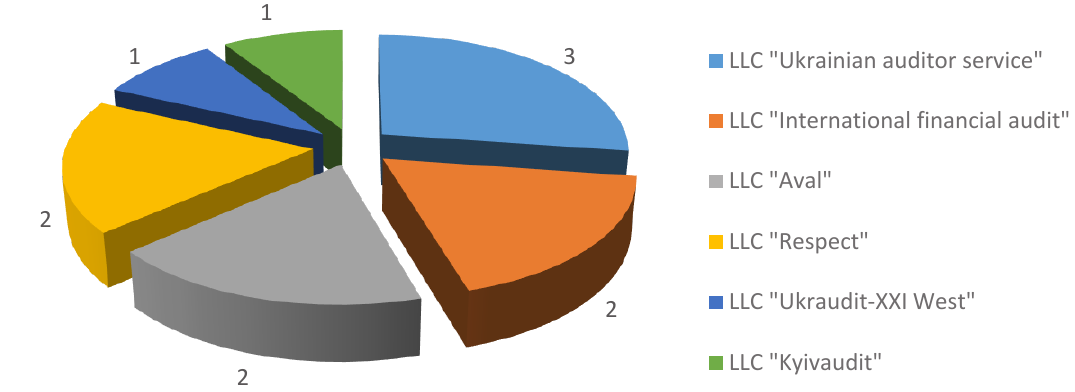
Figure 6. Audit portfolio of Ukrainian banks of Ukrainian audit